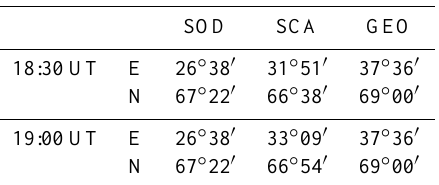
Table 1. Location of Sodankyl¨a, and footprints of GEOS-2 and SCATHA, respectively.